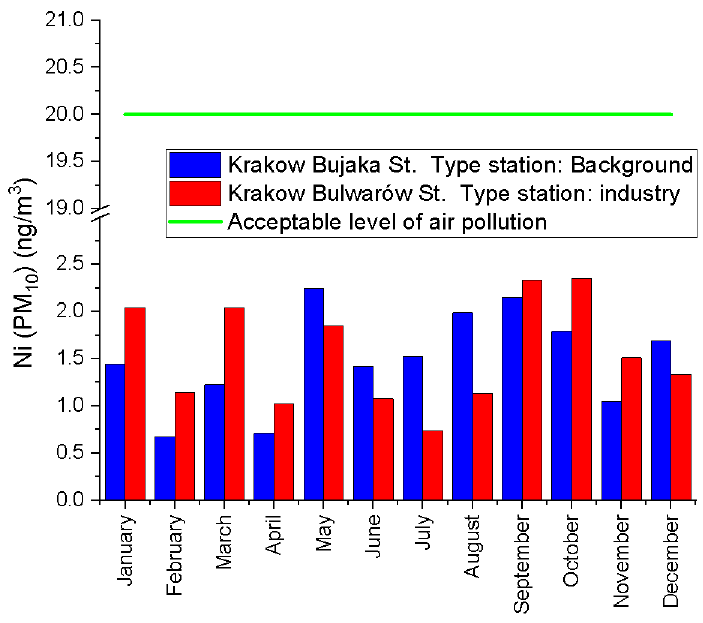
Figure 8. Average daily concentration of Ni (PM10) in individual months of 2020. The highest average daily concentration of Cd in dust was recorded in December at the background station at a value of 0.64 ng m − 3 , while the lowest was in June at the representative station for air quality assessment at 0.17 ng m − 3 at the reported concentration of 5 µg m − 3 (Figure 9).